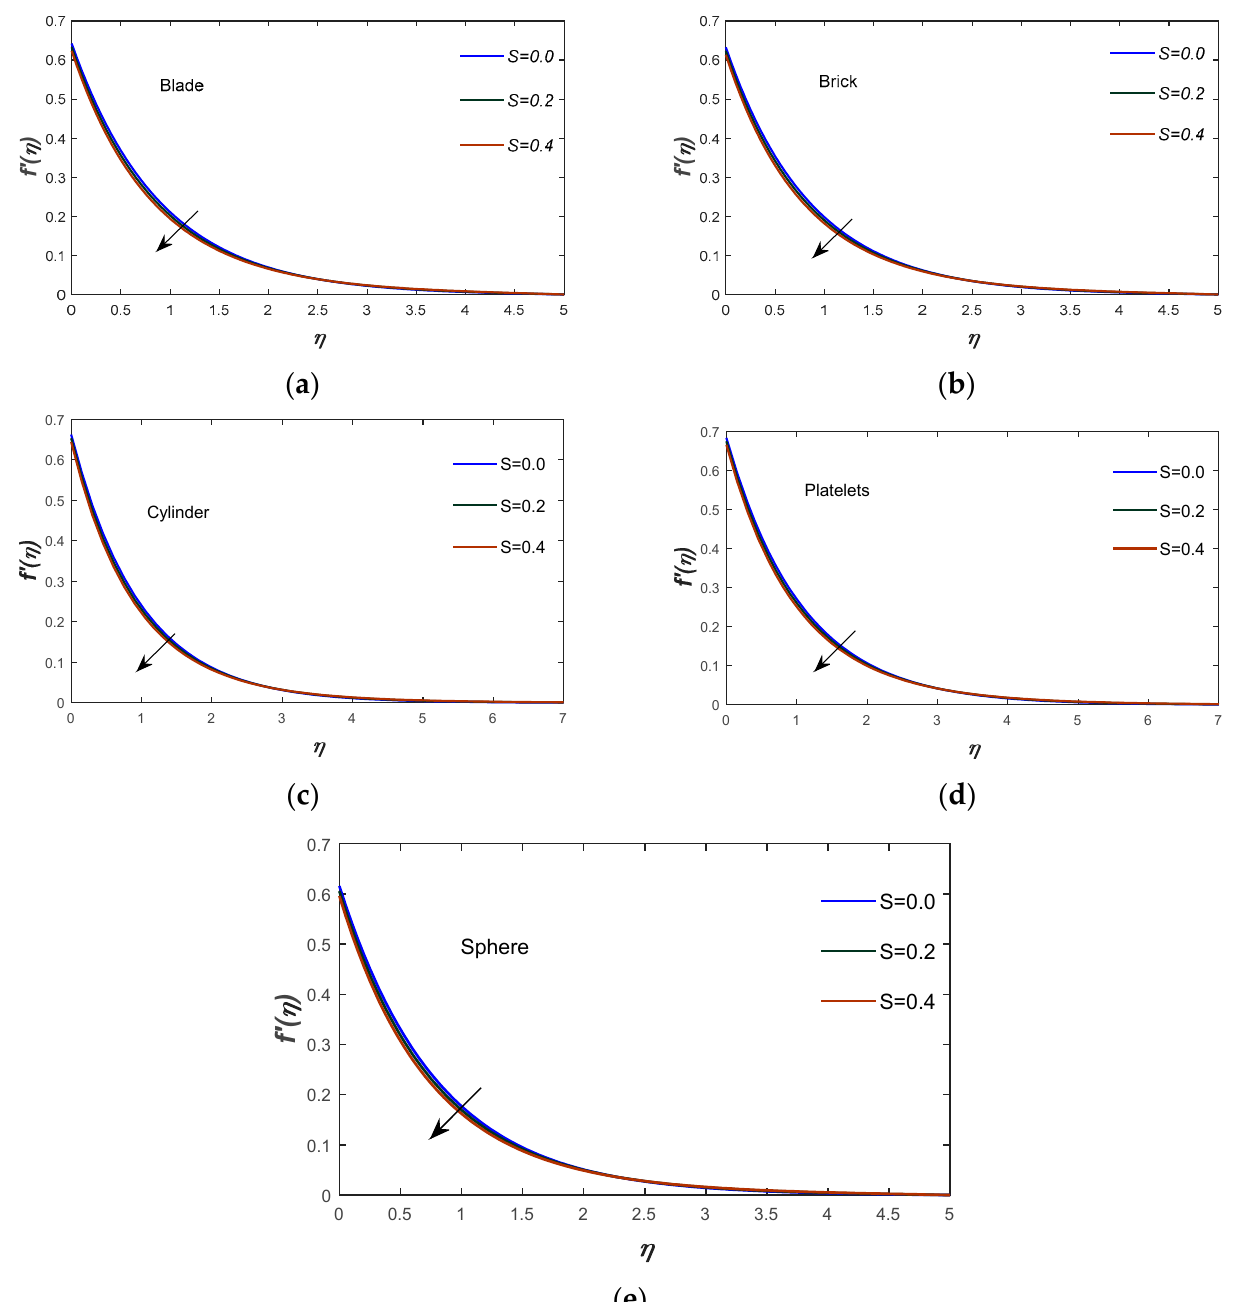
Figure 3. ( a – e ). Impact of 𝑆 on 𝑓′(𝜂) by using various shapes factors of nanoparticles for fixed 𝑀 = 1.0, 𝑃𝑟 = 6.0, 𝑘 = 0.5, 𝐸𝑐 = 1.0, 𝜑 = 0.02 .